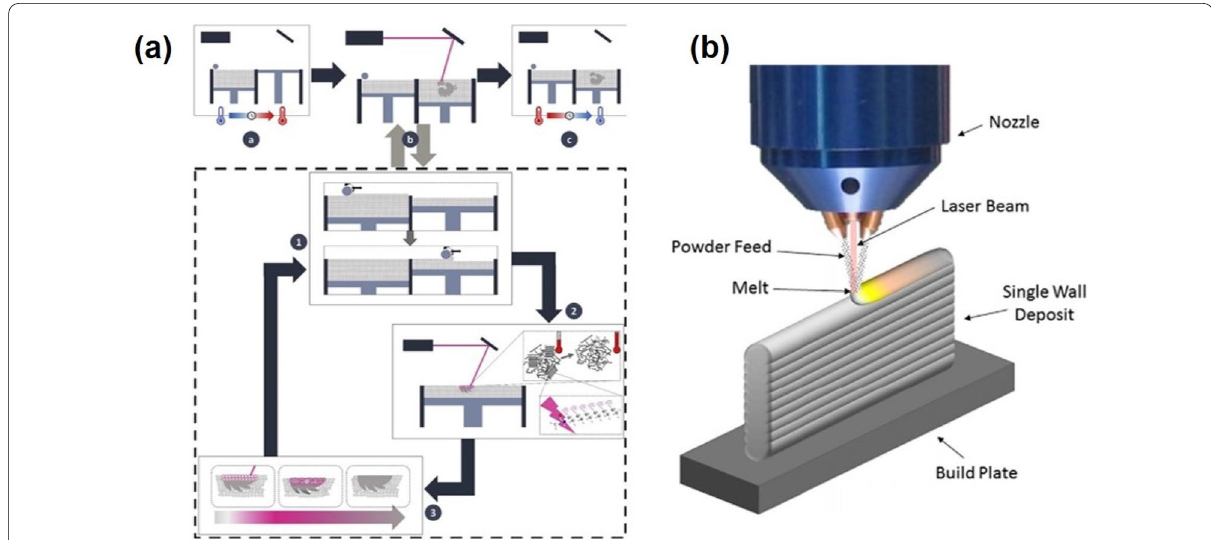
Fig. 1 a Schematic illustration of powder bed fusion additive manufacturing process [59]. b Schematic illustration of directed energy deposition additive manufacturing process